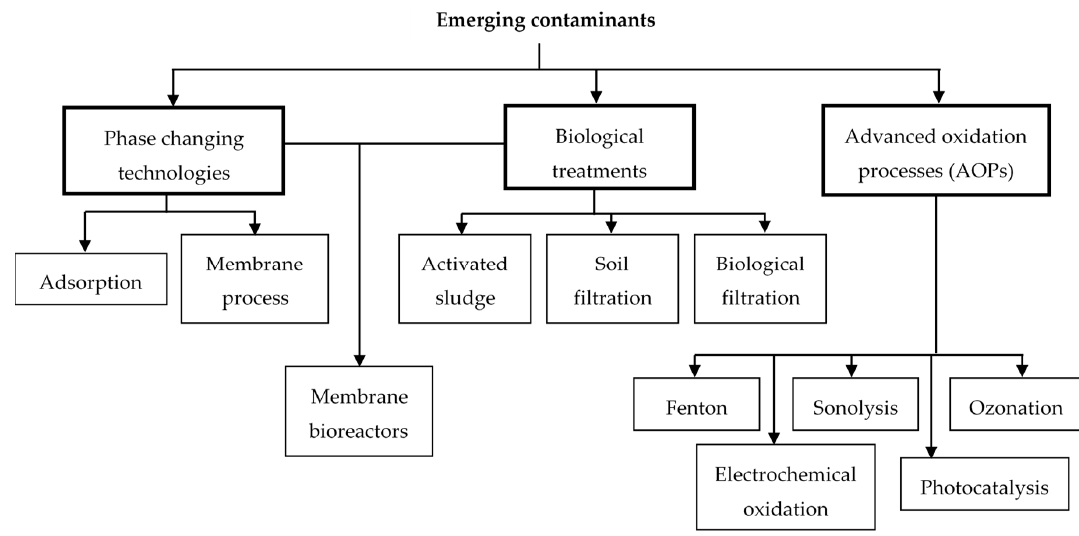
Figure 1. Available technologies for the removal of ECs from wastewater.